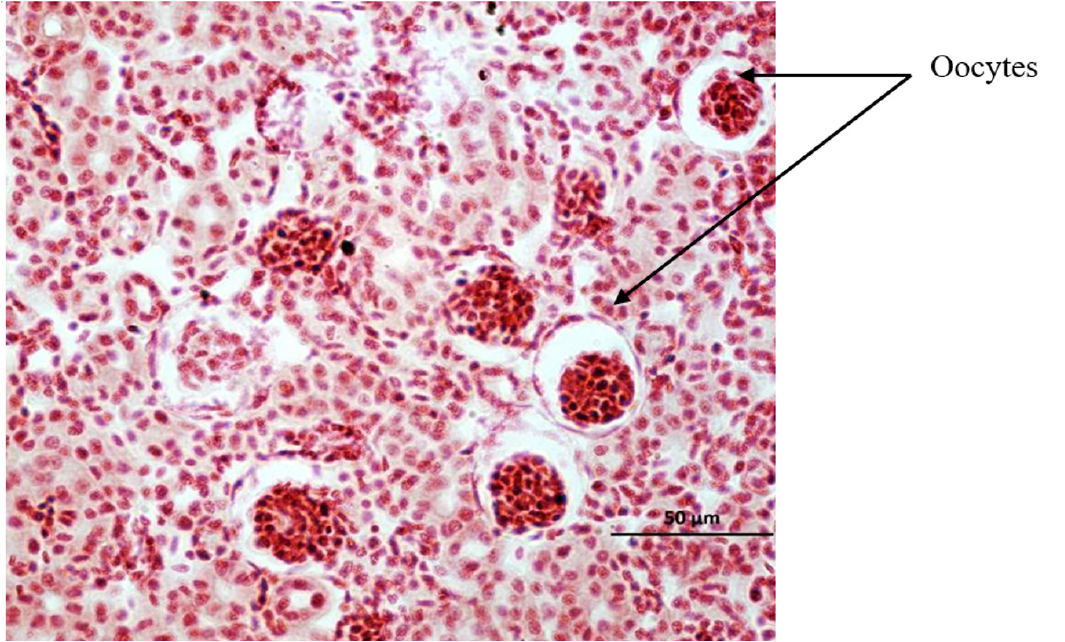
Figure 3: Histological preparations of testes of male frogs of P. cruciger at Gosner stage 42 exposed to carbosulfan. Multiple oocytes surrounded by follicle cells with seminiferous tubules are shown by